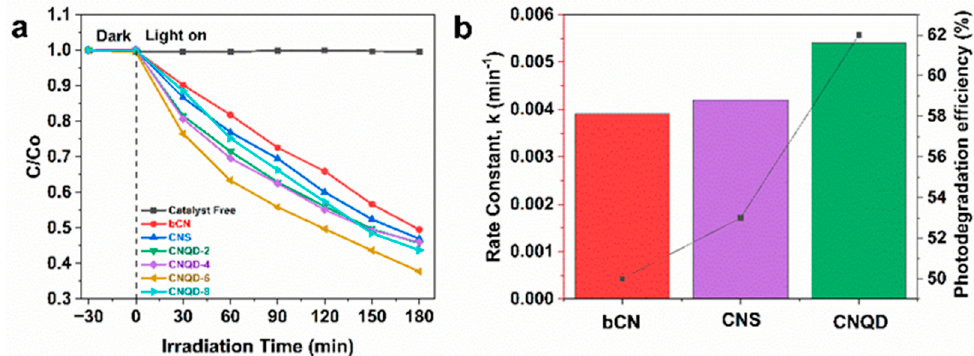
Figure 12. Photolysis of DCF ( a ) using bCN, CNS, and CNQD photocatalysts; DCF degradation efficiency and kinetic rate constant of each photocatalyst under the irradiation of visible light ( b ).